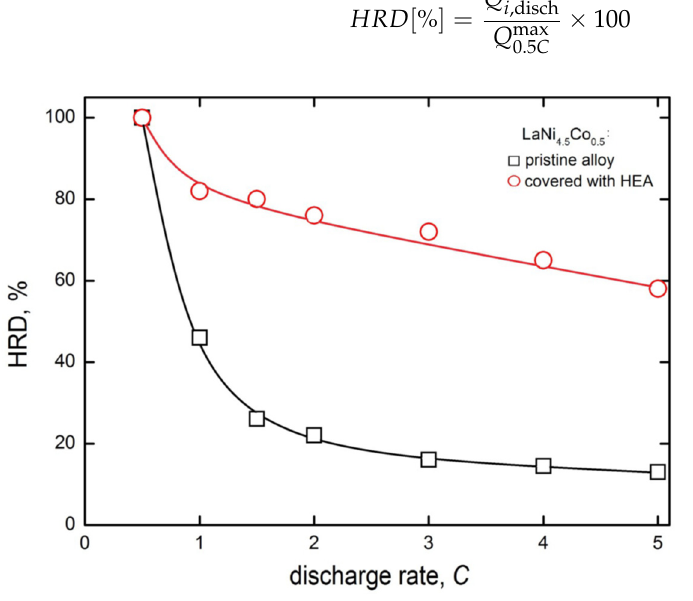
Figure 7. High rate dischargeability for electrodes made of pristine and HEA-modified LaNi 4.5 Co 0.5 powders of HSM after 60 charge/discharge cycles ( − 0.5 C /+0.5 C ) in 6M KOH (Ar, 22 °C).